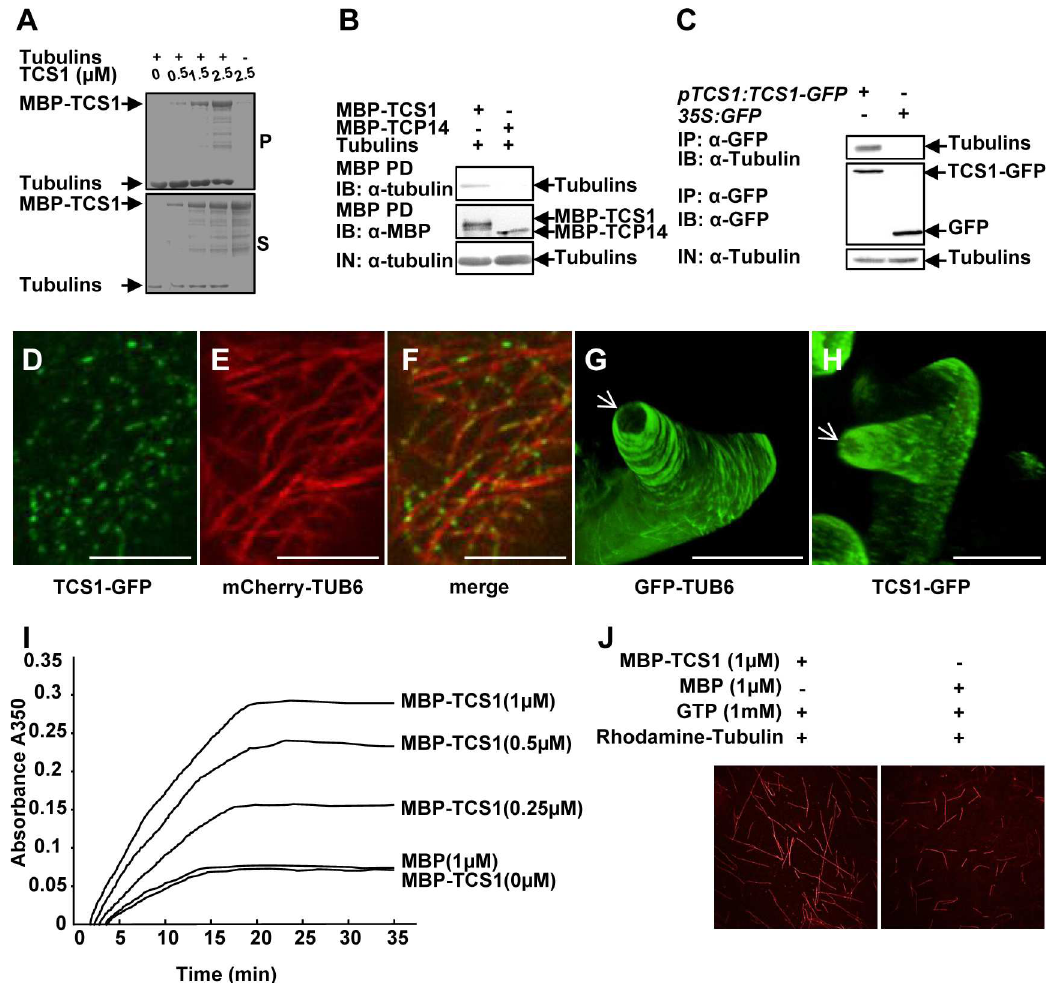
Fig 5. TCS1 binds to microtubules and promotes microtubule assembly. (A) MBP-TCS1 fusion protein was cosedimented with paclitaxel-stabilized microtubules prepolymerized from 8 μ M tubulins. After high-speed centrifugation, the amount of MBP-TCS1 in pellets (P) increasedwhen higher concentrations of MBP-TCS1 proteins were added. MBP-TCS1 mostly appearedin the supernatant(S) in the absence of tubulins. (B) TCS1 directly interacts with tubulins in vitro . Tubulins were pulled down (PD) by MBP-TCS1 immobilized on amylose resin and analyzedby immunoblotting (IB) using an anti-tubulinantibody. MBP-TCP14 was used as a negative control.(C) TCS1 interacts with tubulins in Arabidopsis. Total proteins from pTCS1 : TCS1-GFP and 35S : GFP transgenic plants were immunoprecipitated (IP) with GFP-Trap-A, and the immunoblot (IB) was detected with anti-GFP and anti-tubulin antibodies, respectively. Tubulins were detected in the immunoprecipitated GFP-TCS1 complex but not in the control (GFP). (D-F) TCS1 colocalizeswith cortical microtubules (MTs) in Arabidopsis epidermal pavement cells. TCS1-GFP (D), mCherry-TUB6 (E) and merged (F) images are shown. TCS1-GFP localizesalong cortical microtubules (mCherry- TUB6) in a punctate pattern. Scale bars = 5 μ m. (G and H) GFP fluorescence of GFP-TUB6 (G) and TCS1-GFP (H) in elongating trichome branches. The white arrows indicate the three dimension(3-D) reconstruction of the microtubule- depleted zone at the extreme apex of elongatingtrichome branches. Bars = 20 μ m.(I) MBP-TCS1 promotes the assembly of microtubules. The time course of tubulin polymerization from 20 μ M tubulins in the presence of different concentrations of MBP-TCS1 was detected turbidimetrically by absorbance at 350 nm. 1 μ M MBP was used as a negative control. (J) Confocal microscopy analysis showed that TCS1 promotes tubulin assembly in vitro . Rhodamine labeledtubulins (20 μ M) were incubatedwith 1 μ M MBP-TCS1 and 1 μ M MBP at 37˚C for 30 min, respectively. Microtubules were visualizedunder confocal